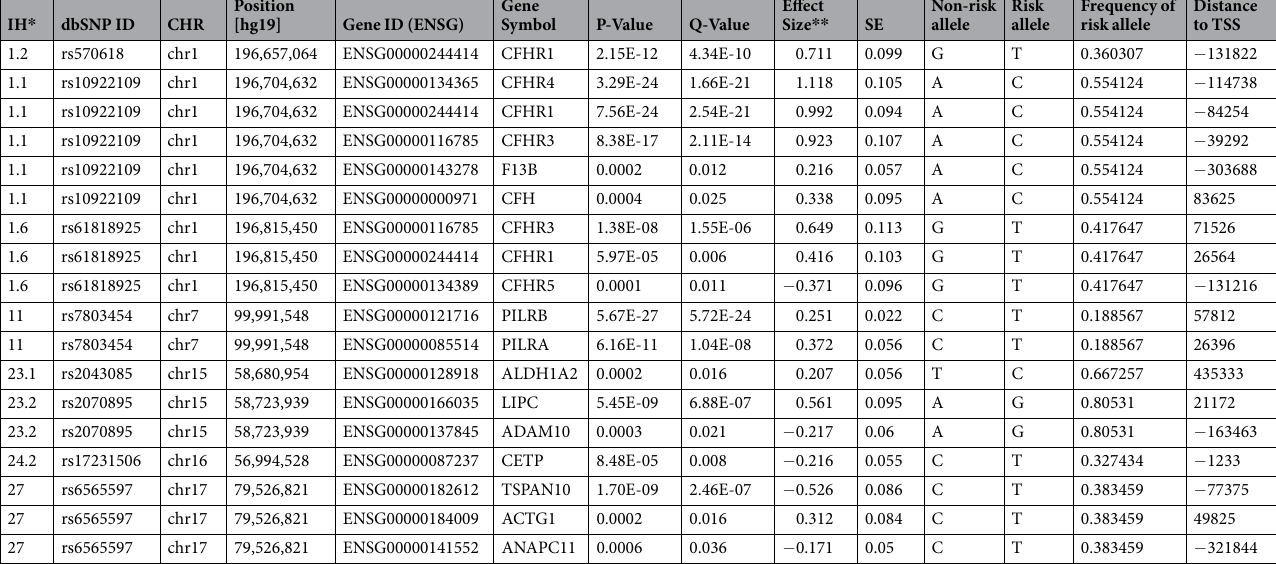
Table 2. eQTL variants overlapping with genome-wide significant AMD variants. CHR: chromosome;